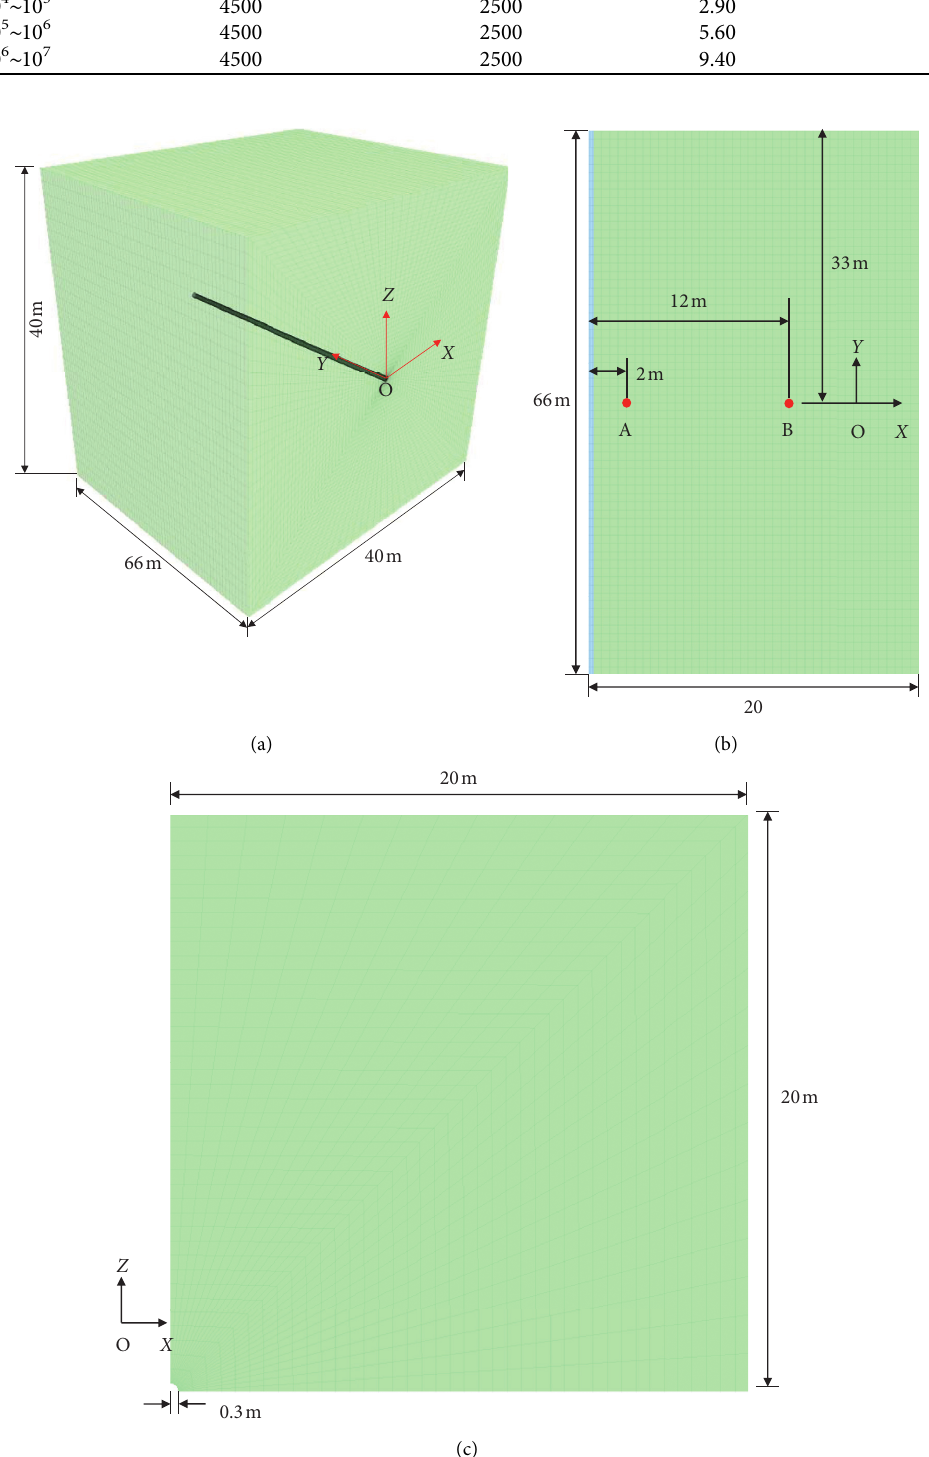
Figure 6: Numerical simulation for dynamic analysis of local damping. (a) Numerical model geometry. (b) Sectional panel of the calibrated model ( z � 0). (c) Sectional panel of the calibrated model ( y �